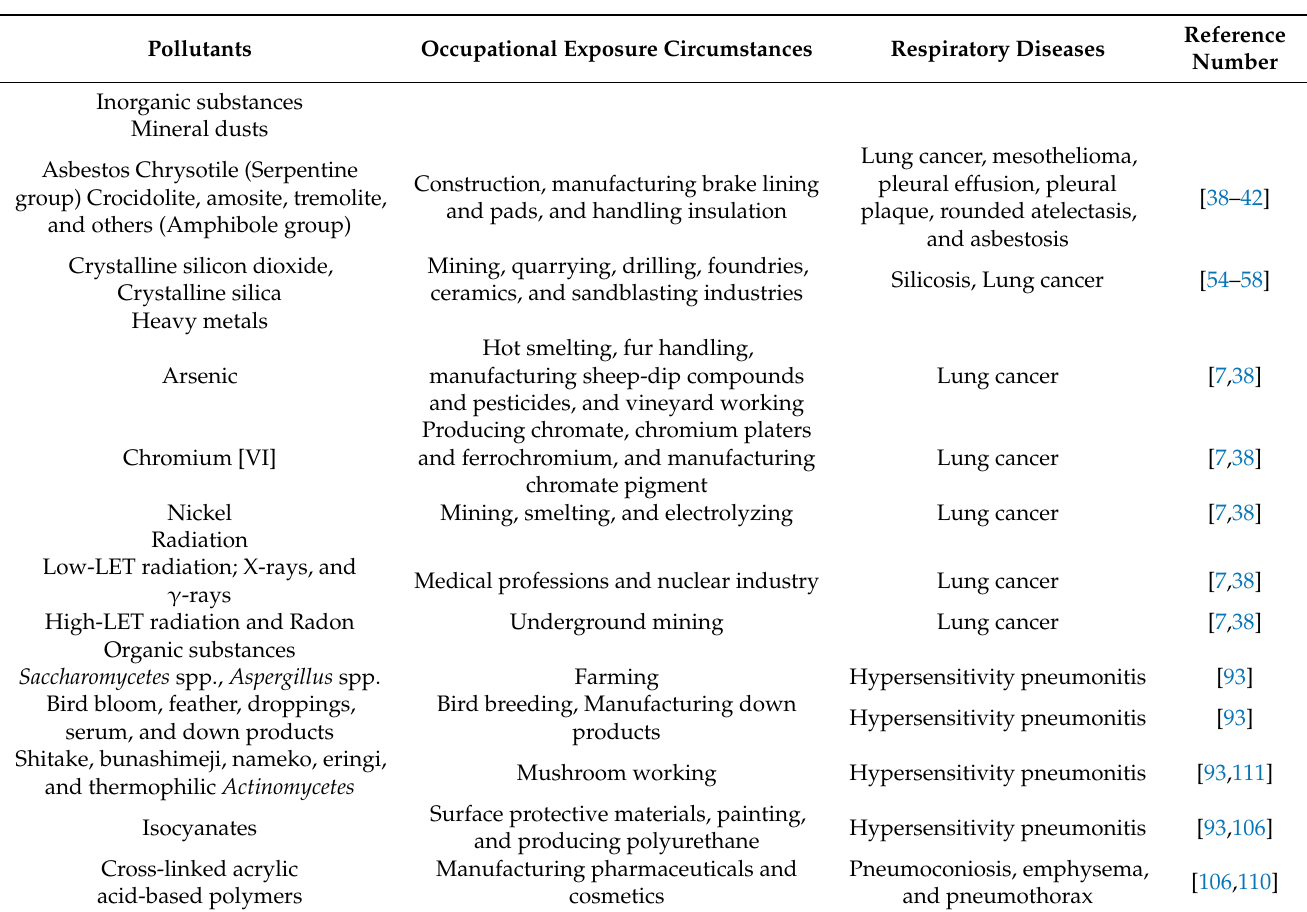
Table 2. Representative occupational pollutants with health effects on the respiratory system (except work-related asthma) in this review.